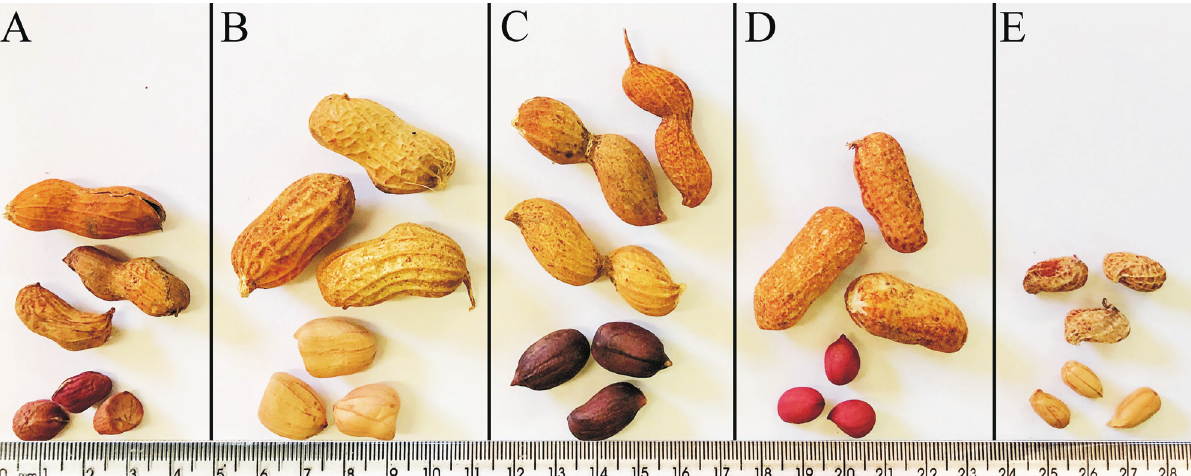
Figure 1 - Pods and seeds of the Arachis genotypes cytogenetically analyzed showing differences in size, color and middle constriction. A) A. hypogaea Xingu/Nambikwara Of 115; B) A. hypogaea subsp. hypogaea var. hypogaea Of 120; C) A. hypogaea “Xingu” type Of 126; D) A. hypogaea subsp. fastigiata var. fastigiata ‘IAC Tatu-ST’ and E) A. monticola V